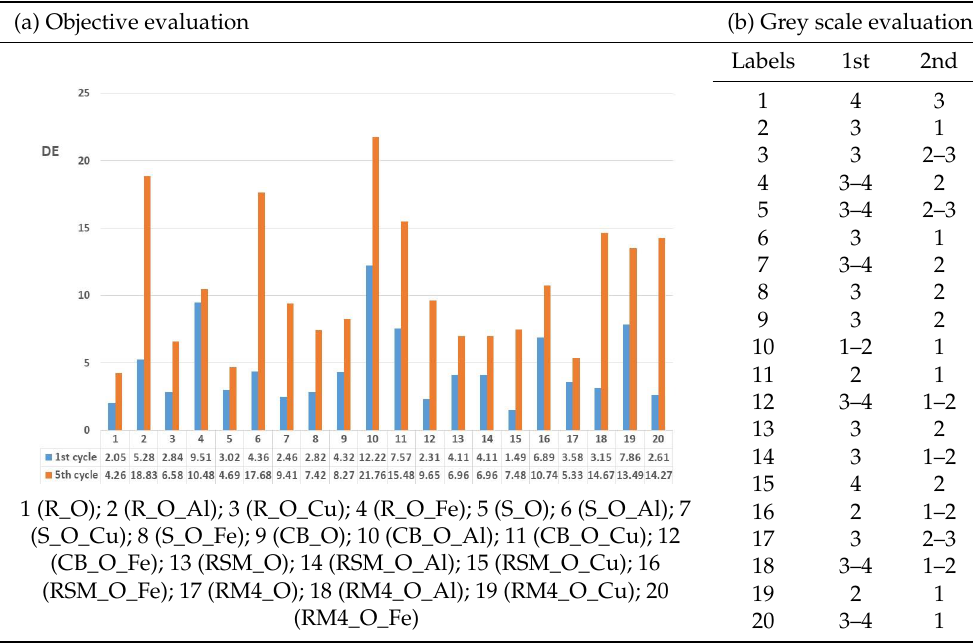
Table 7. Colour fastness to washing after 1st and 5th cycles of washing of cotton yarns dyed with onion peel.